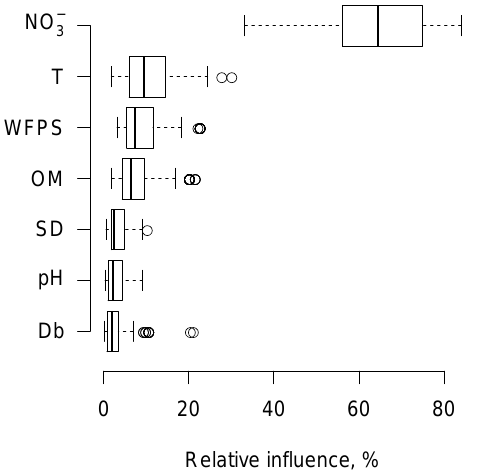
Fig. 4. Boxplots (description of quartiles with maximum at 1.5 interquartile range) of relative influences of the 7 tested input variables, as revealed by the ANN7(OM,pH,Db,SD)G model. Circles are outlier candidates.